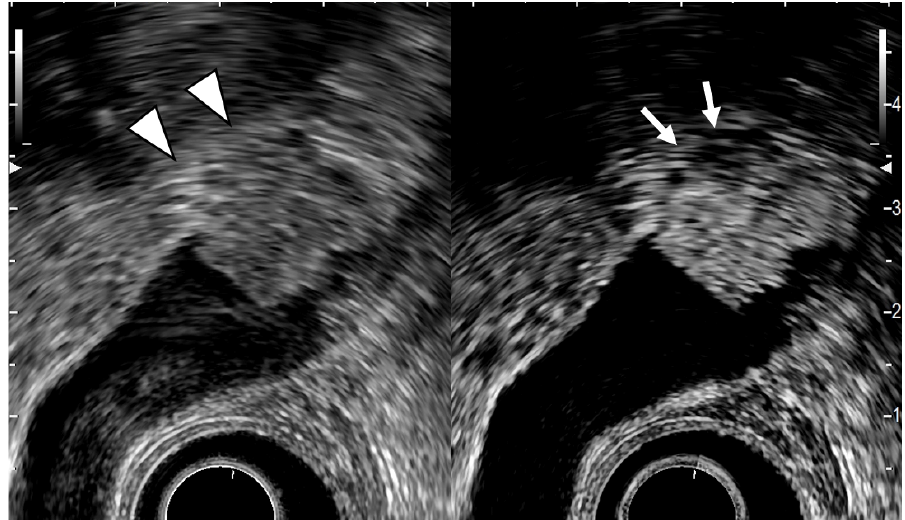
Figure 6. EUS image of GB carcinoma. The conventional EUS ( left ) shows that a broad-based elevated lesion is found at the fundus of the GB with hypoechoic (arrowhead) in the deep part of the lesion and rupture of the lateral hyperechoic layer. In the contrast-enhanced EUS ( right ), the contrast effect of most of the lesion is good, but the deep part of the lesion is poorly contrasted (arrow). It can be diagnosed from these findings as GB carcinoma with invasion depth T3a (SE). Table 5. EUS classification of GB carcinoma and correlation with T staging (adapted from [49]). EUS Classification